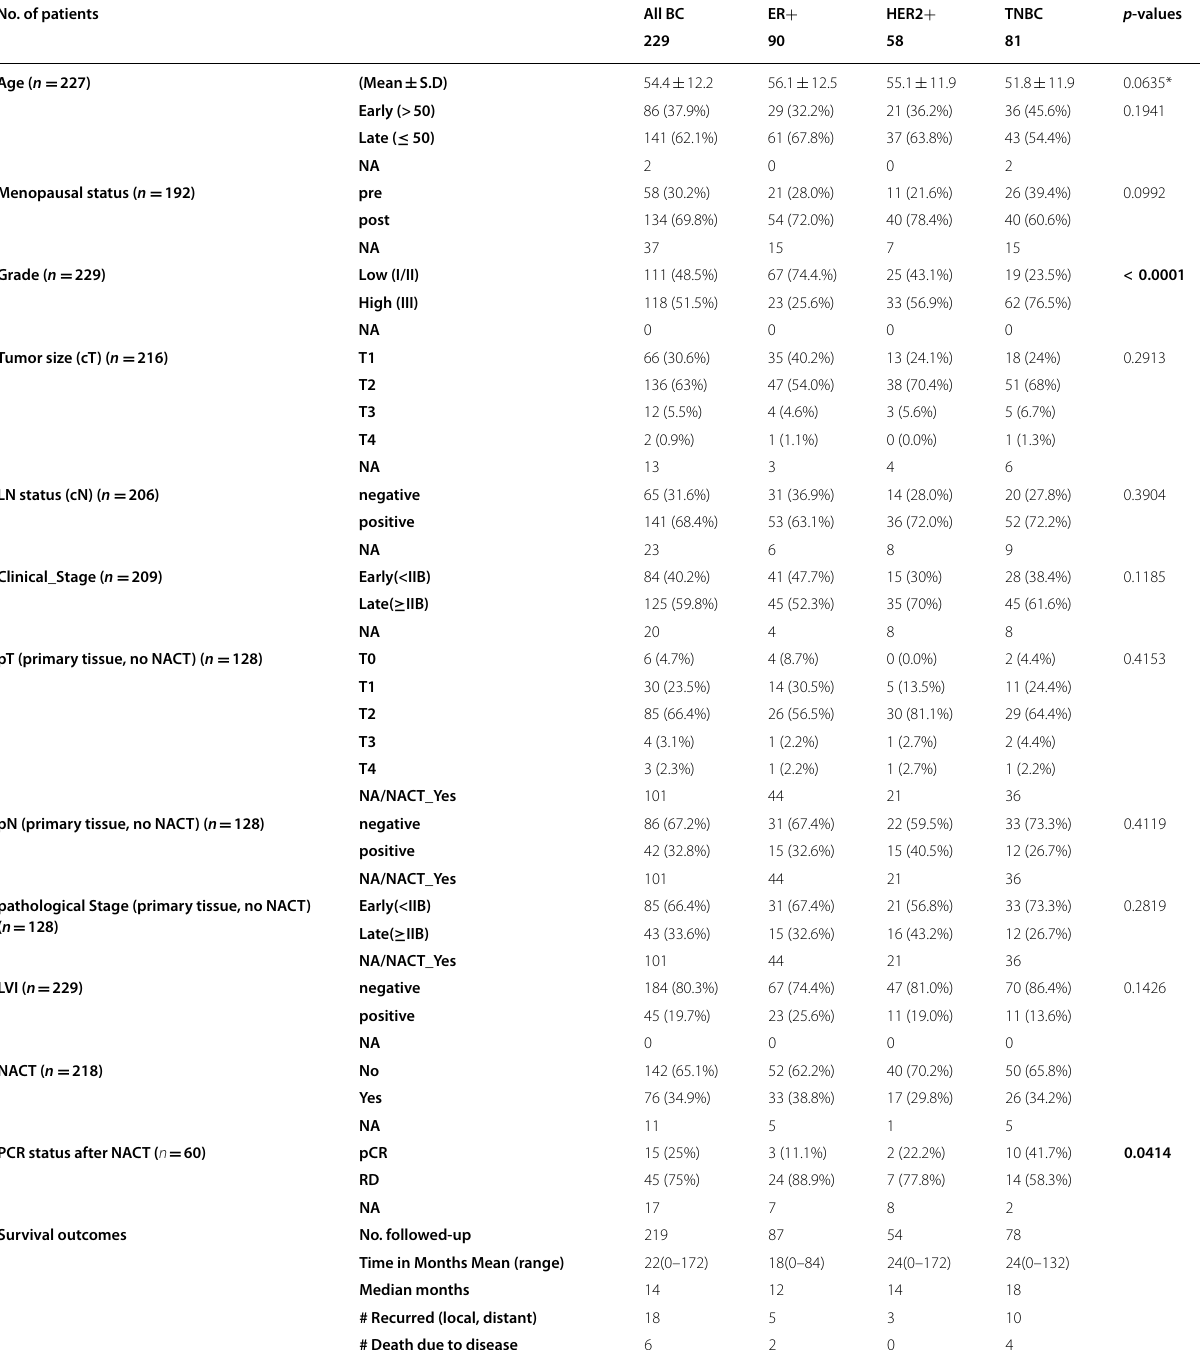
Table 1 Demographic table of the breast cancer cohort, with clinical characteristics across